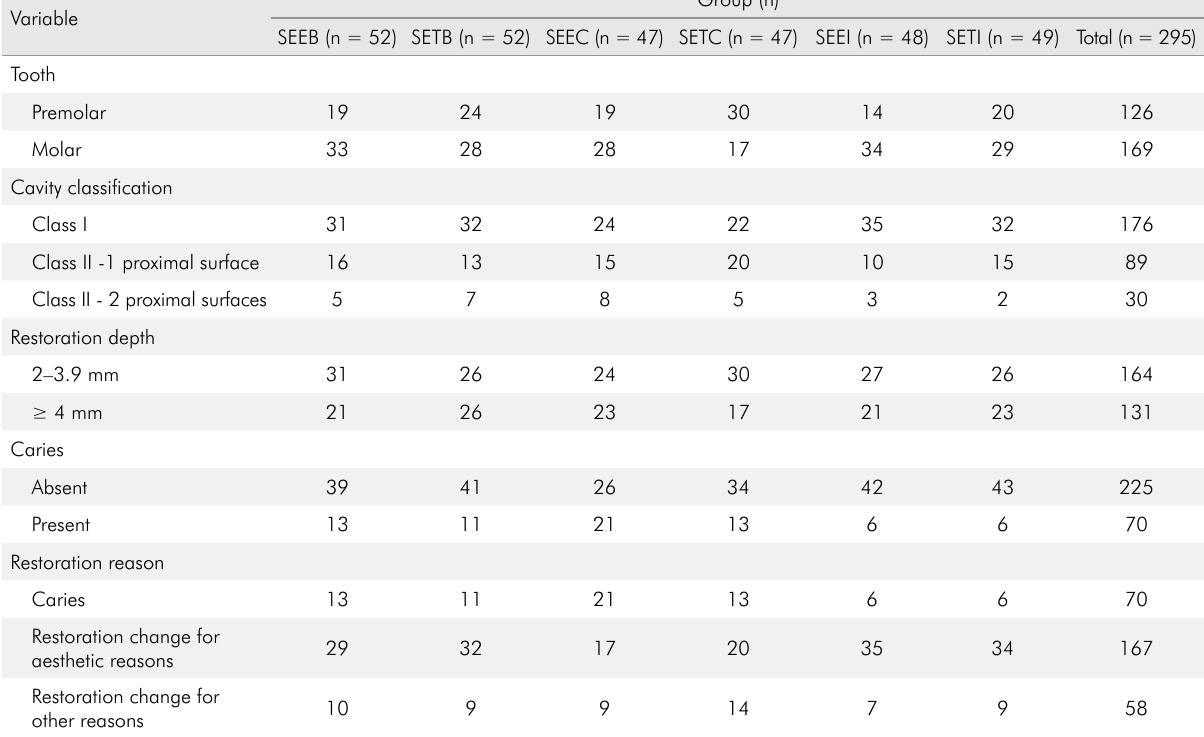
Table 2. Characteristics of arches and